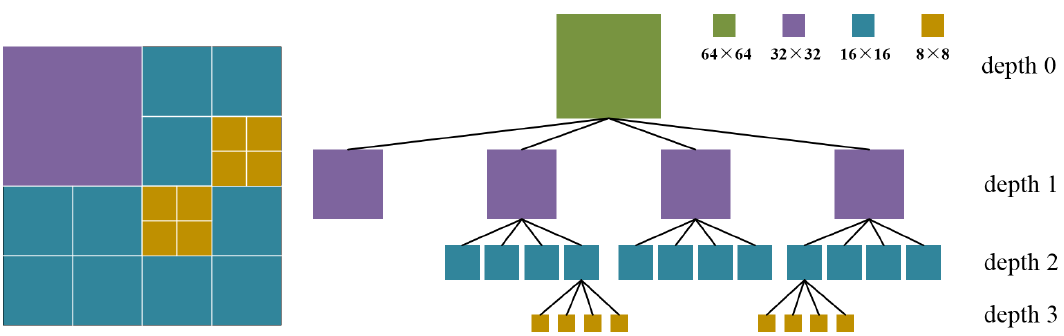
Figure 2. A partition example of a CTU and the corresponding quad-tree splitting structure in the HEVC intra coding.